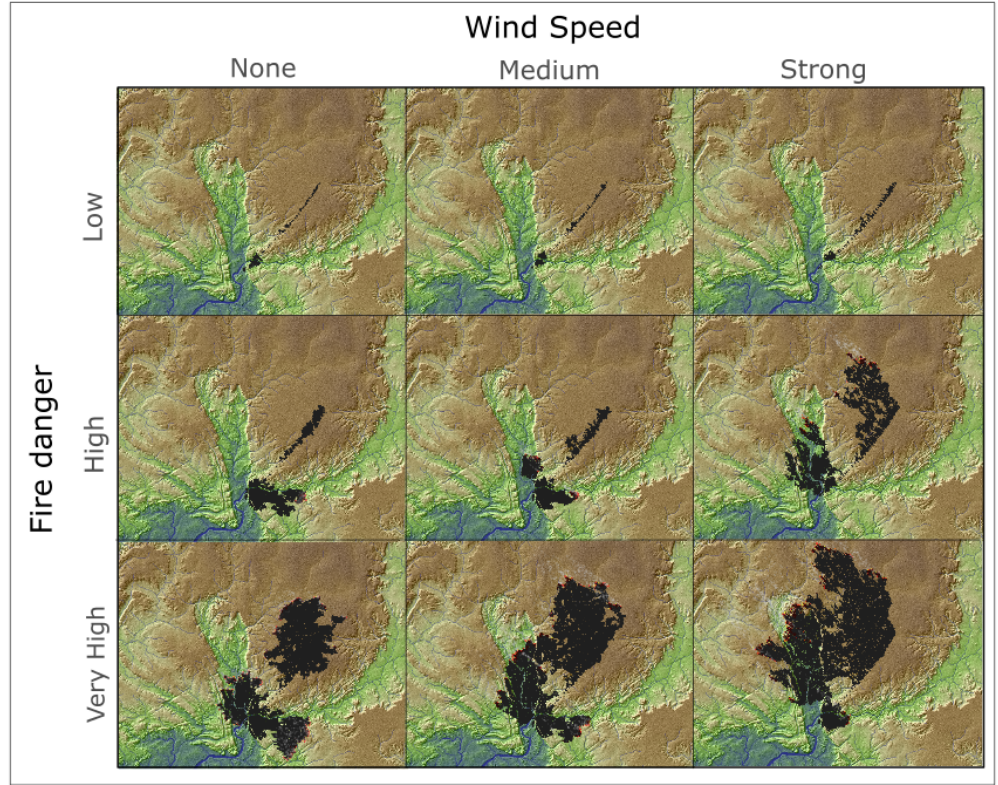
Figure 4. Simulated fire spread matrix based on a combination of three fire danger settings (Low, High, Very High) and three windspeed settings (None, Medium, Strong).